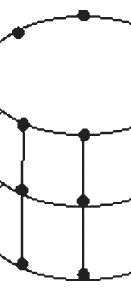
S and TBI. Due to the difficulty of matching subject numbers between the three groups with neurological